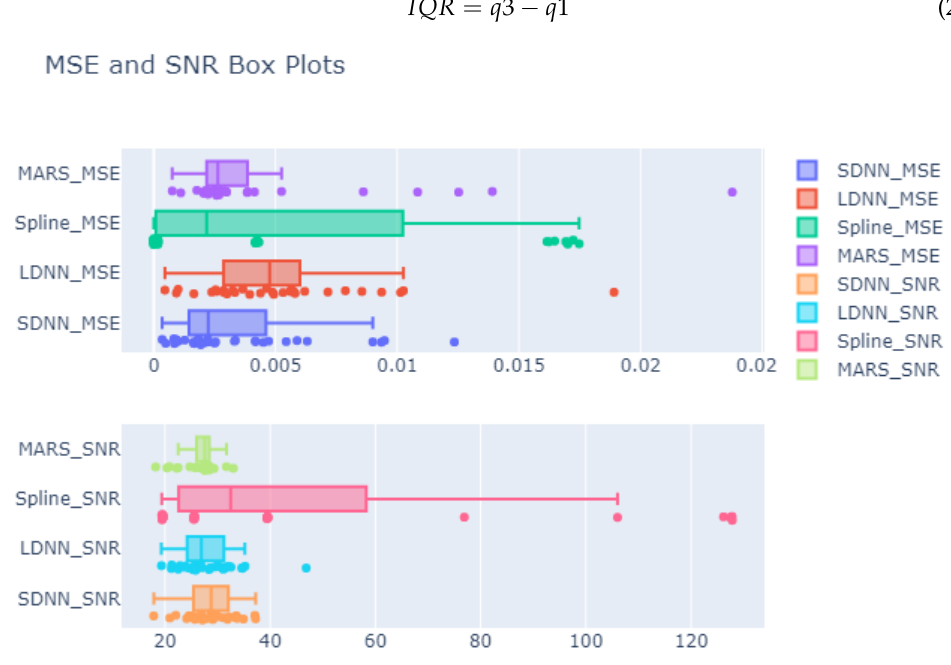
Figure 4. Boxplots for MSE and SNR values attained from all experiments. The average of five runs is presented. The first row shows the MSE for the SDNN, LDNN, splines and MARS test sets. The second row shows the respective SNR values. The box represents the 1st and 3rd quantiles, while the middle line represents the median value. The left vertical line represents the value Q 1 − 1.5 IQR , while the right line is Q 3 + 1.5 IQR . Values outside of the vertical lines are outliers. The splines model has three separate regions in which most observations are